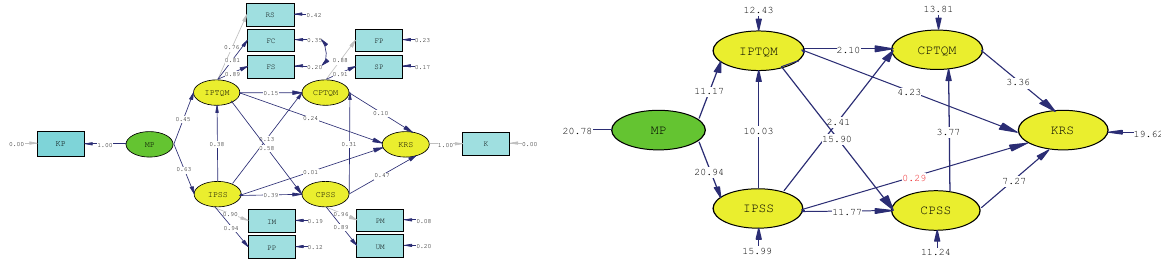
Fig. 3. Hospital QMA Model Path Diagram (t-value)